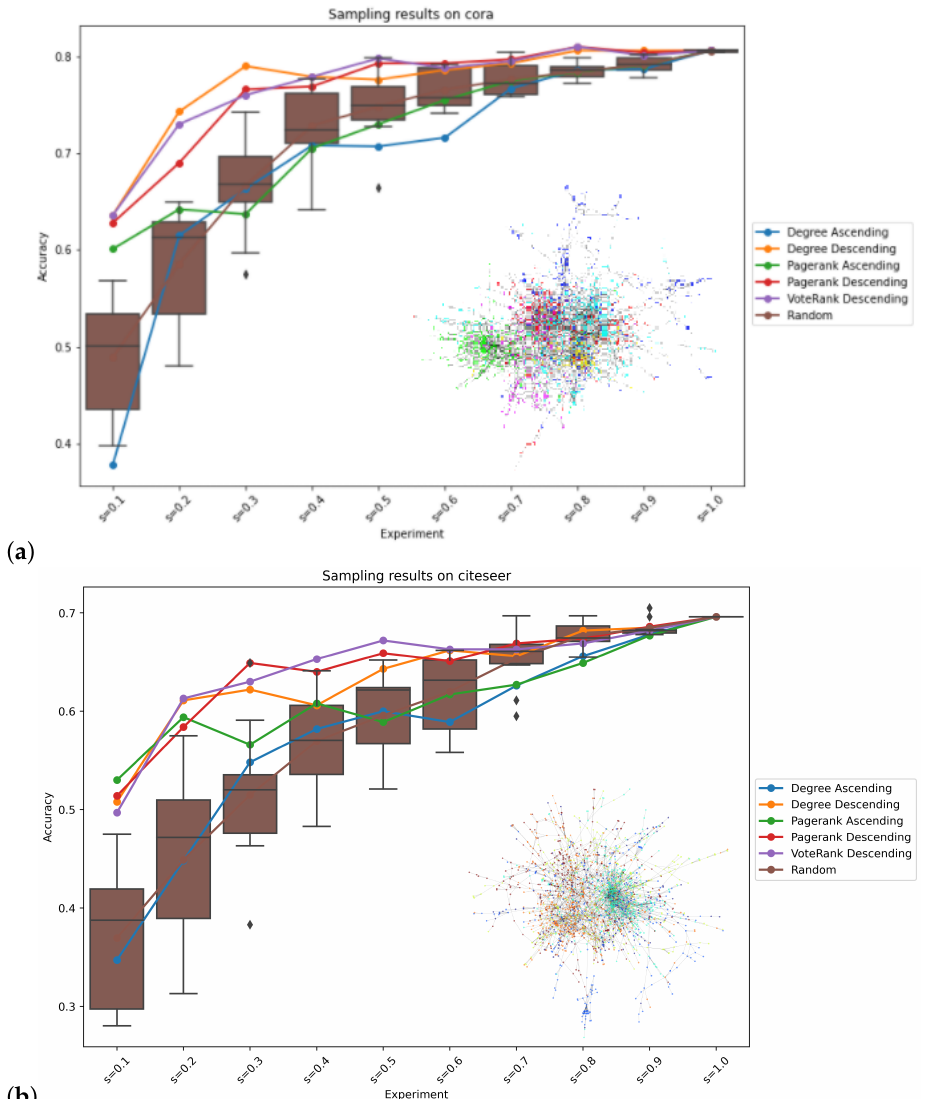
Figure 1. Here is presented the accuracy of the class predictions for the network node sample ratio using different node selection strategies. The large values of CV d for the network (Cora ( a ), Citeseer ( b )) graph has higher accuracies when sampling nodes from the highest score to lowest score (i.e., ‘descending’ methods), showing the effectiveness of the node-ranking algorithms on a node classification